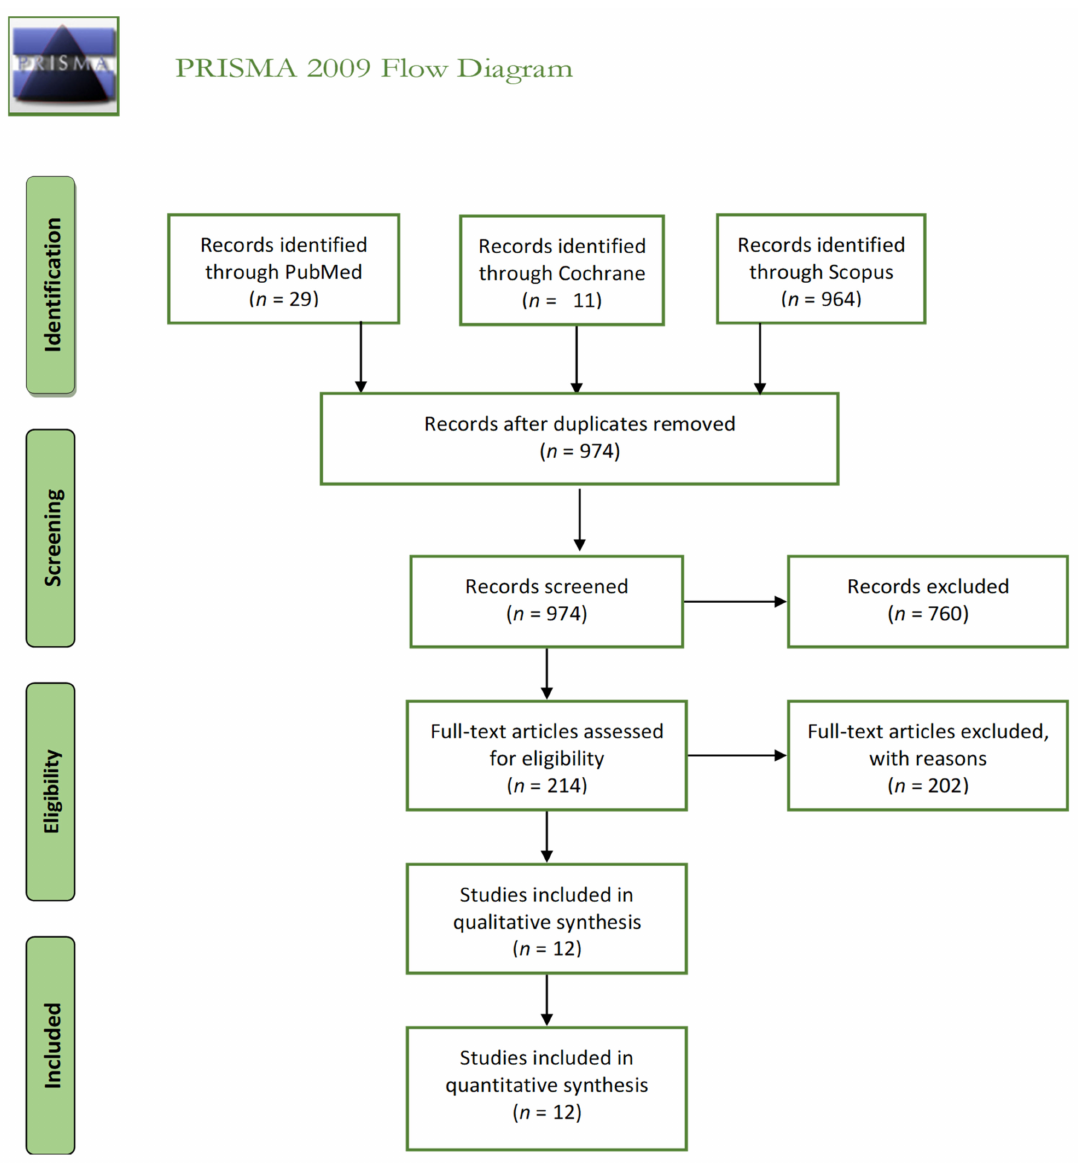
Figure 1. The Preferred Reporting Items for Systematic reviews and Meta-Analyses (PRISMA) flow